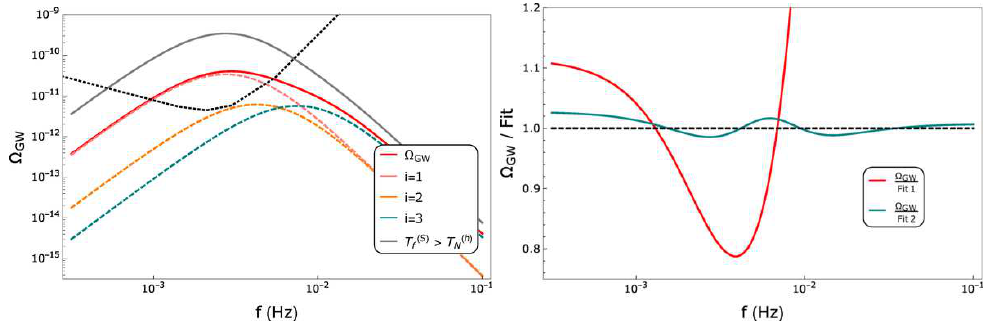
Figure 7 . Left panel: the spectrum due to simultaneous singlet and EW PT, given by the red line, leads to a different spectrum than consecutive transitions (gray line). Here we have chosen the second benchmark of table 1, with w 1 = 0 . 1 and w 2 = 1 w 3 = 0 . 15, and v (2 , 3) w = (0 . 6 , 0 . 99). − The dotted line is the projected sensitivity from LISA [90]. Right panel: comparison of a fit to a single and separated phase transition. It is seen that it is not possible to fit to a single peak spectrum. The fit to a doubly peaked spectrum is better, but still cannot mimic the features in the simultaneous bubble